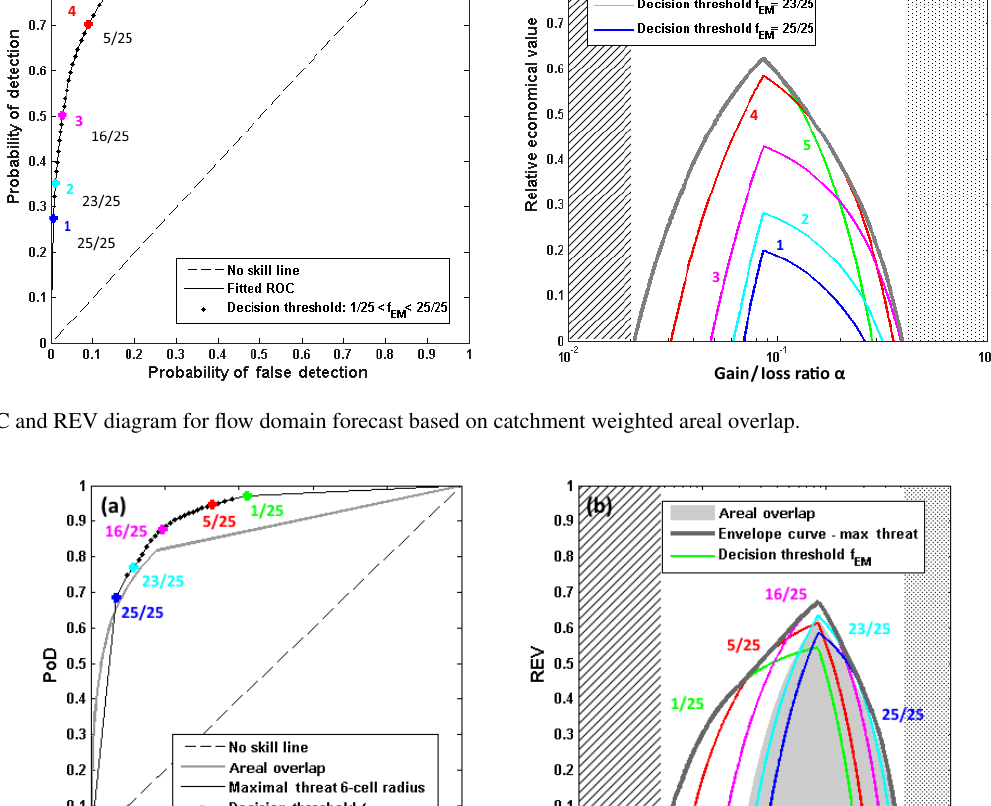
The ROCA of each approach is respectively 0.86 and